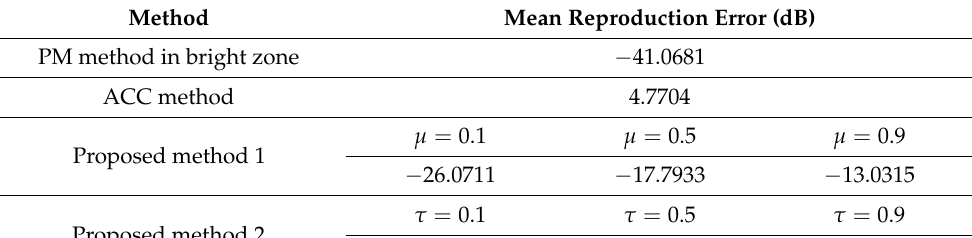
Table 7. Mean normalized spatial average error of different methods relative to frequency for three-dimensional experiment.